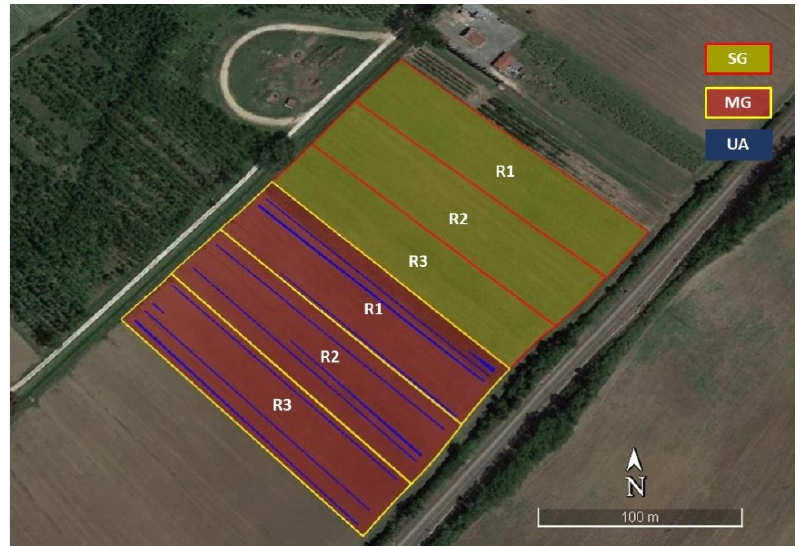
Figure 4. Unsown areas (UA) identified in the treatment MG; not present in treatment SG.